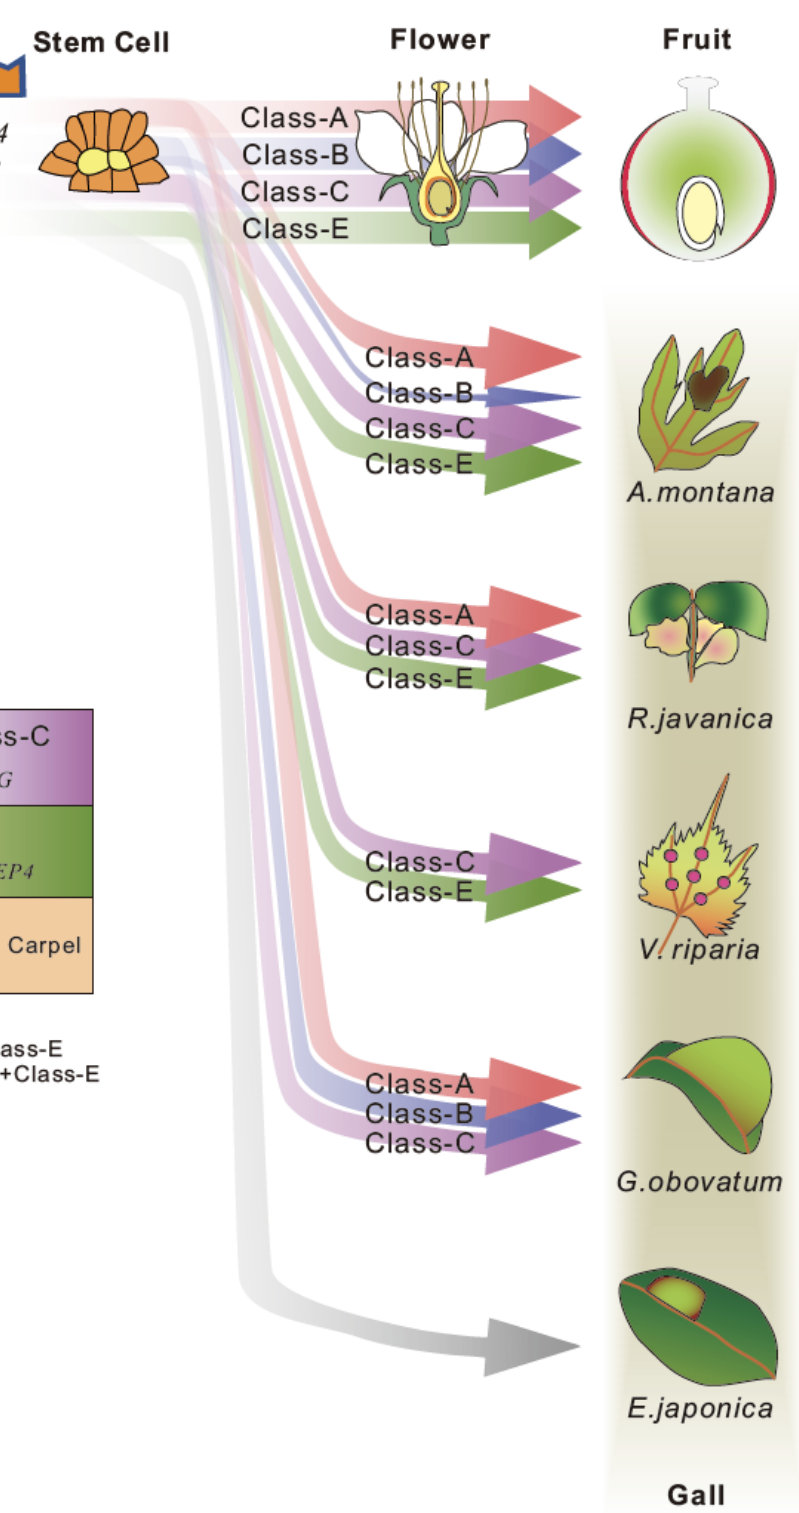
Figure 3. A hypothesis of gall formation processes in various host plants. Common candidate genes for stem cell generation and floral organ development were extracted from transcriptome data of developing galls of A. montana , G. obovatum [7], R. javanica [40] and V. riparia [60]. The thickness of arrow indicates the expression level of each gene. The gall formation hypothesis explains the gall formation mechanism that sepal and carpel-based galls are generated by the ectopic over expression of class-A, class-B, and class-E floral homeotic genes on leaves in A. montana and R. javanica , or carpel-based gall is generated by the expression of class-C and E genes in V. riparia . No floral homeotic genes need for generation of pouch-type thin gall of E. japonica